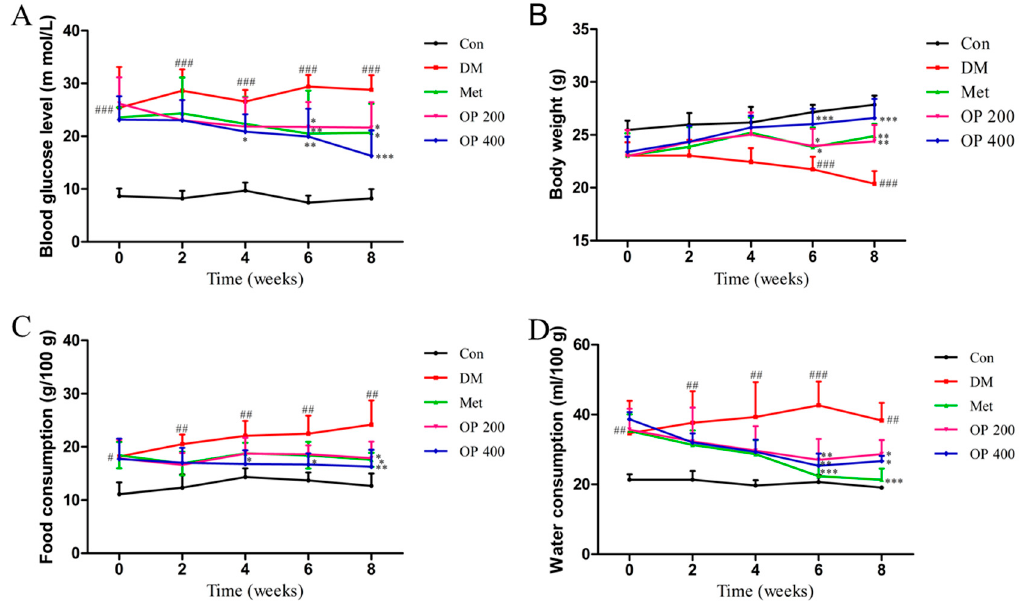
Figure 1. Effects of okra (OP) on fasting blood glucose level ( A ), body weight ( B ), food consumption ( C ) and water consumption ( D ). Data are expressed as means ± standard deviation (SD; n = 10). Con—control group treated with 0.5% sodium carboxyl methyl cellulose (CMC-Na) per day; DM—type 2 diabetes melltius (T2DM) treated with 0.5% CMC-Na per day; Met—T2DM mice treated